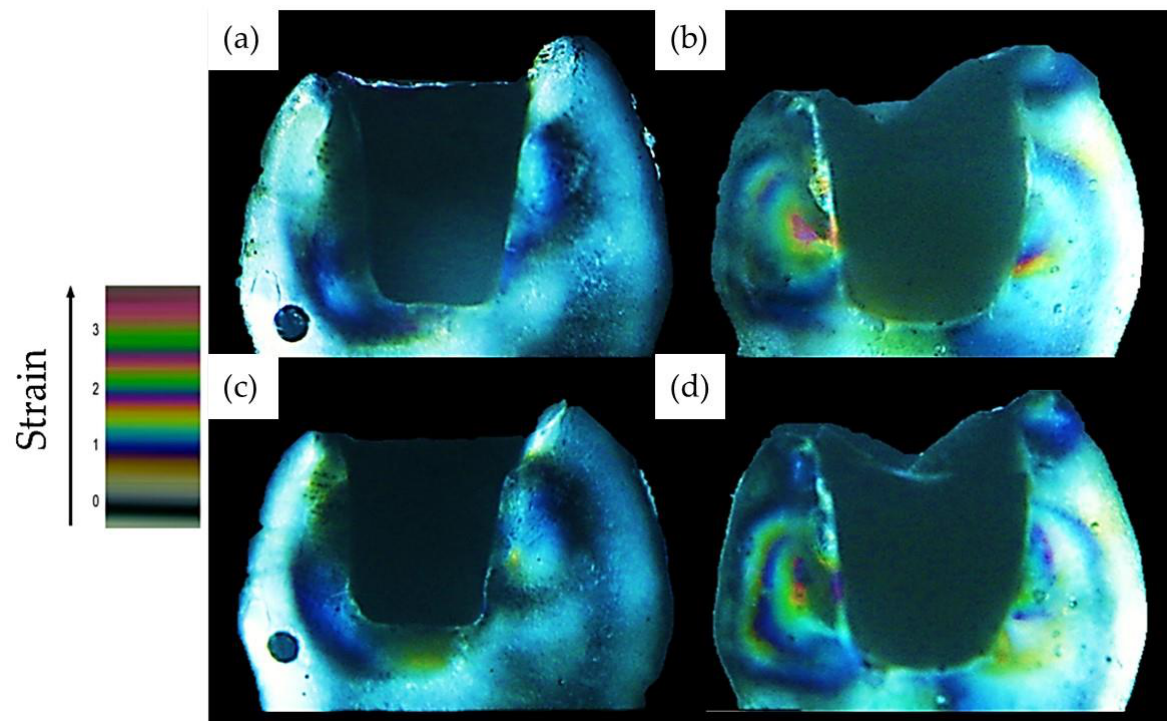
Figure 3. Qualitative analysis: Group 1 with 100 μm thickness without forming first order fringes immediately ( a ) and after 24 h ( c ). Group 2 with 400 μm thickness showed second order fringe immediately ( b ) and after 24 h ( d ).